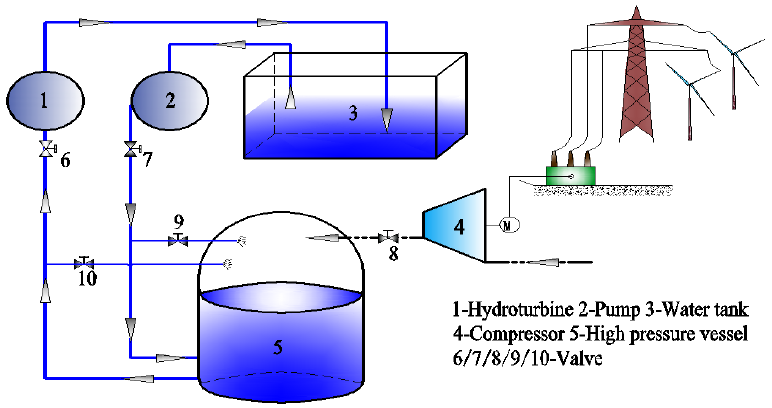
Figure 2. Schematic of the